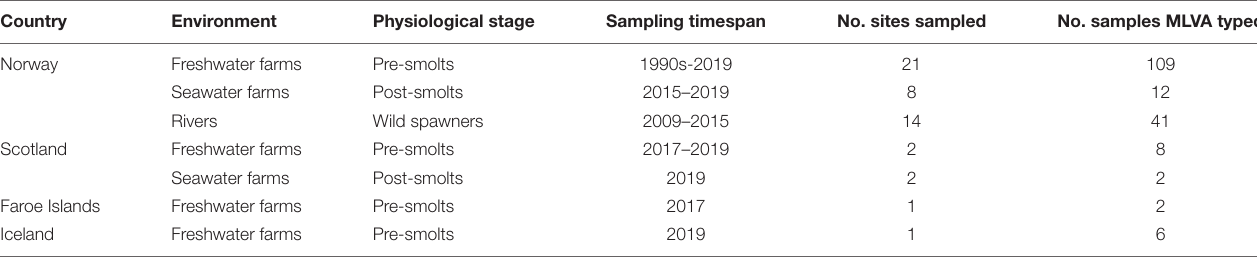
TABLE 1 | From the 310 Atlantic salmon gill samples testing positive for SGPV by qPCR, the table shows the origins of the 180 samples successfully MLVA typed in the present study. Country